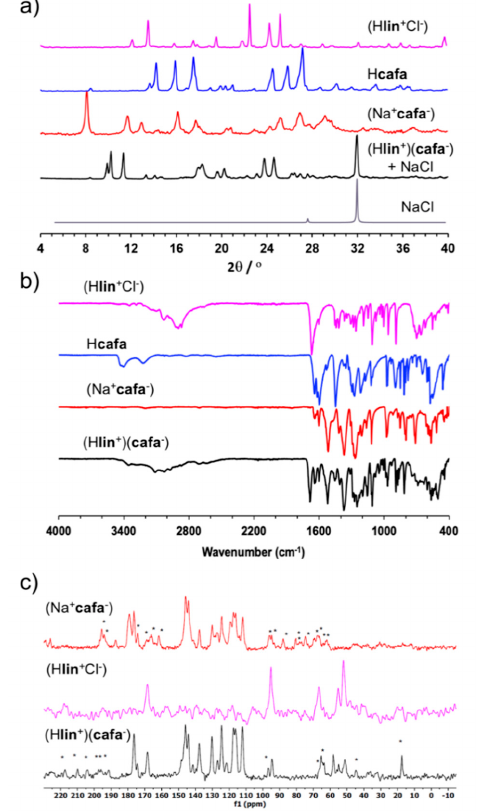
Figure 4. Comparison of relevant: ( a ) PXRD patterns; ( b ) FTIR-ATR spectra and ( c ) 13 C ssNMR spectra for the synthesis of linsidomine caffeate (H lin + )( cafa − ). The ssNMR side bands in ( c ) are designated by ‘*’.